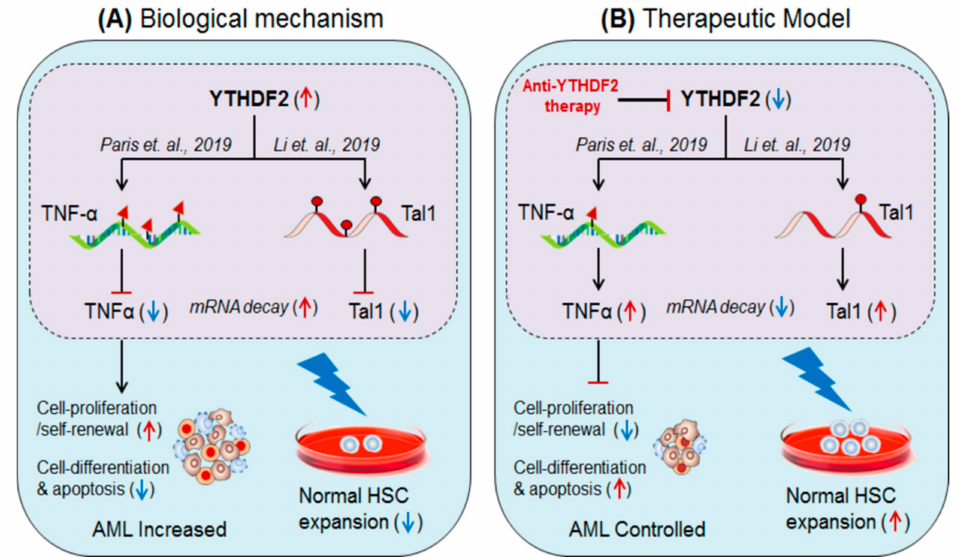
Figure 5. Therapeutic model targeting intracellular m6A-reader protein ‘YTHDF2 (cid:48) in controlling AML, and in expanding normal HSCs for BM-transplant. ( A ) Biological mechanisms: YTHDF2 facilitates leukaemia progression by suppressing TNF- α [54]. Whereas, hyper-methylation of Tal1 causes HSC-limitations during BM/stem cell transplant [53] ( B ) Therapeutic model: Anti-YTHDF2 therapy controls AML progression as well as allows normal HSCs expansion in vitro by targeting respective genes via mRNA-decay